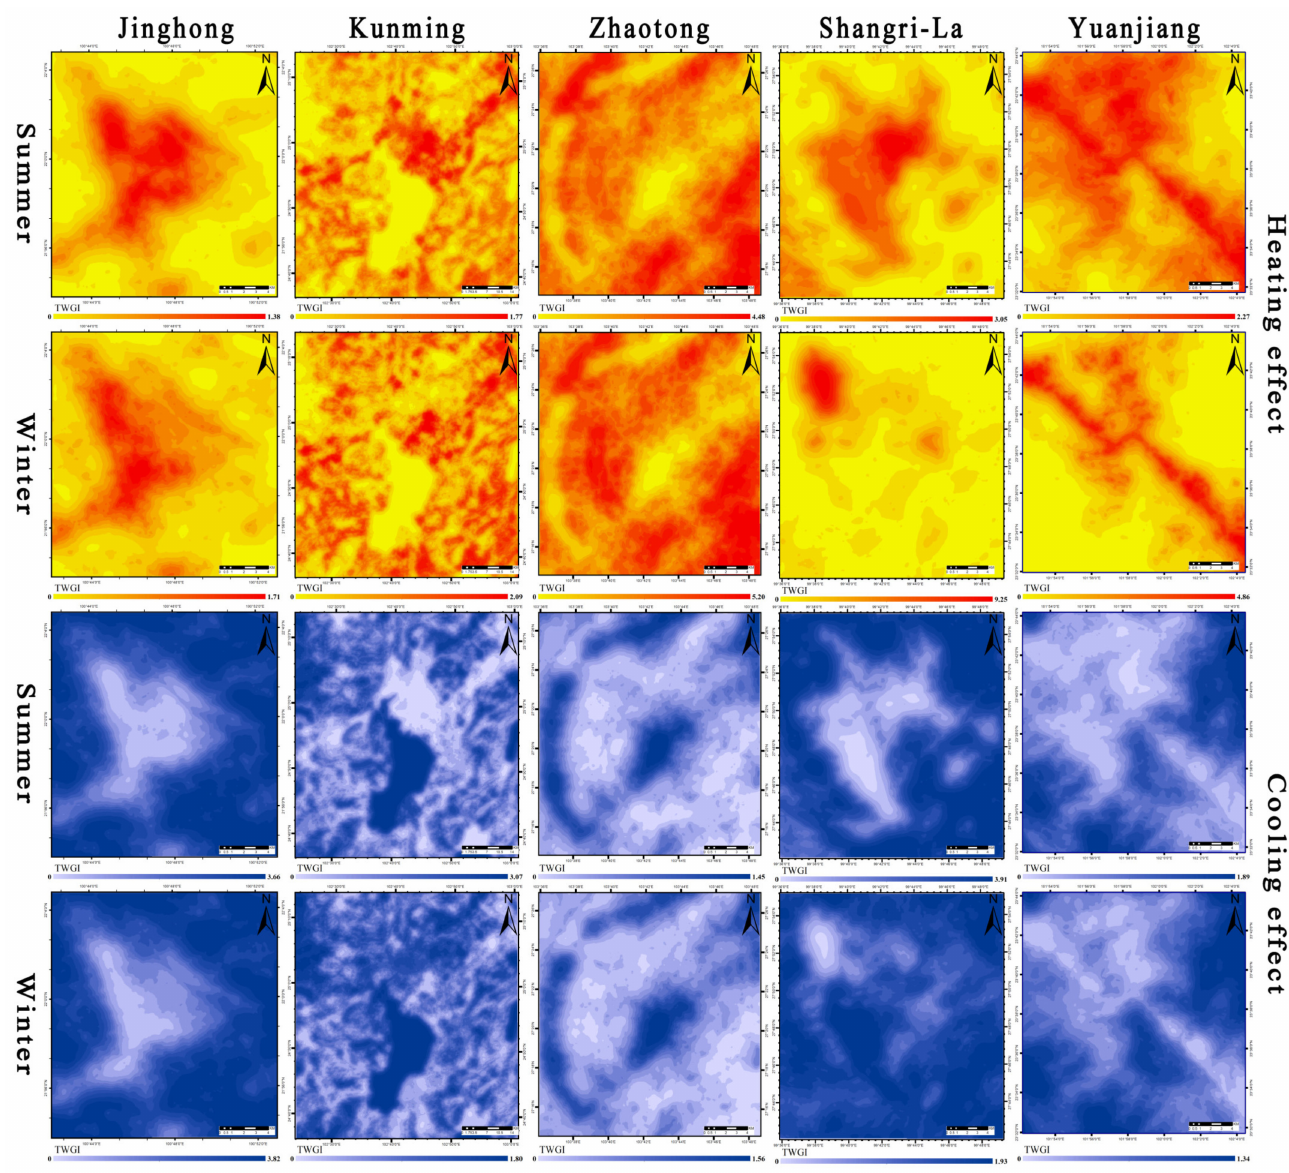
Figure 6. The TWGI distributions in five cities (the red color represents the heating effect, and the blue color represents the cooling